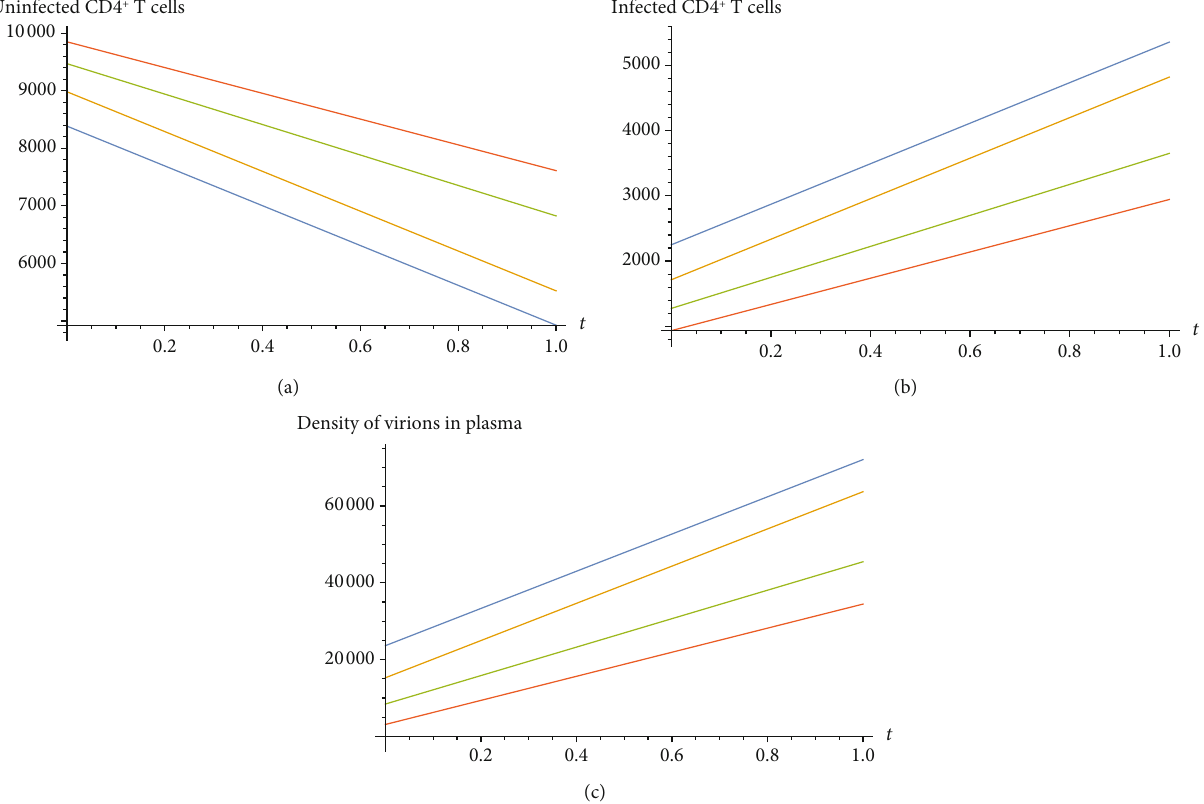
Figure 1: The graphical results to show the (a) uninfected CD4 + T cells, (b) infected CD4 + T cells, and (c) density of virions in plasma for di ff erent order fractional derivatives in sense of Caputo-Fabrizio operator, where blue represents graph for β = 0 : 3 , yellow for β = 0 : 5 , green for β = 0 : 7 , and red for β = 0 : 9 ,